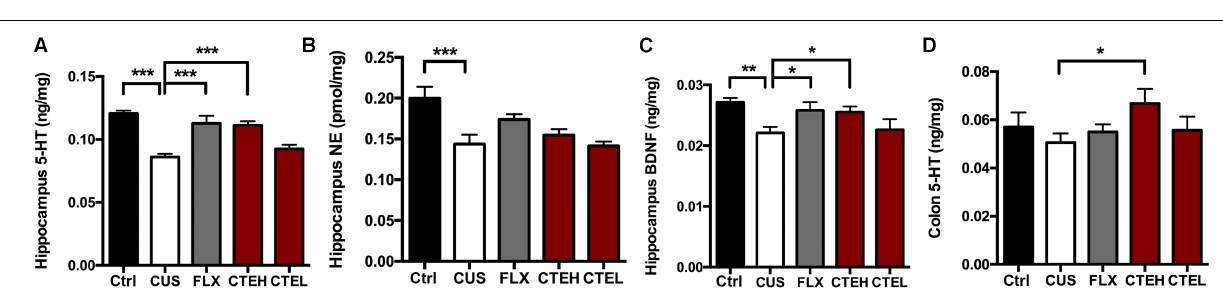
FIGURE 2 | The changes of monoamine neurotransmitter levels in hippocampus and colon of CUS rats treated with CTE: 5-HT (A) , NE (B) , and BDNF (C) in hippocampus, and 5-HT in colon (D) . Ctrl, control; CUS, chronic unpredictable stress; FLX, fluoxetine; CTEH, C. tubulosa extract high dose; CTEL, C. tubulosa extract low dose. ∗ P < 0.05, ∗∗ P < 0.01, ∗∗∗ P < 0.001 ( n = 8, mean ± SEM).